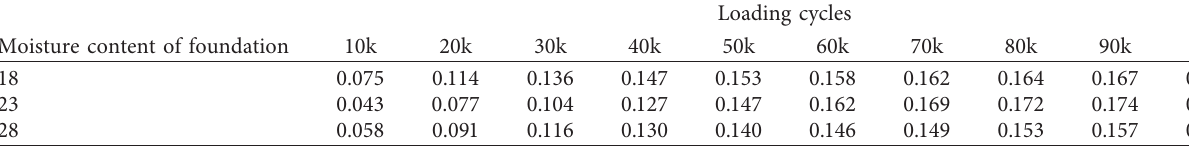
Table 4: Cumulative stress rate of subgrade top under different loading cycles.